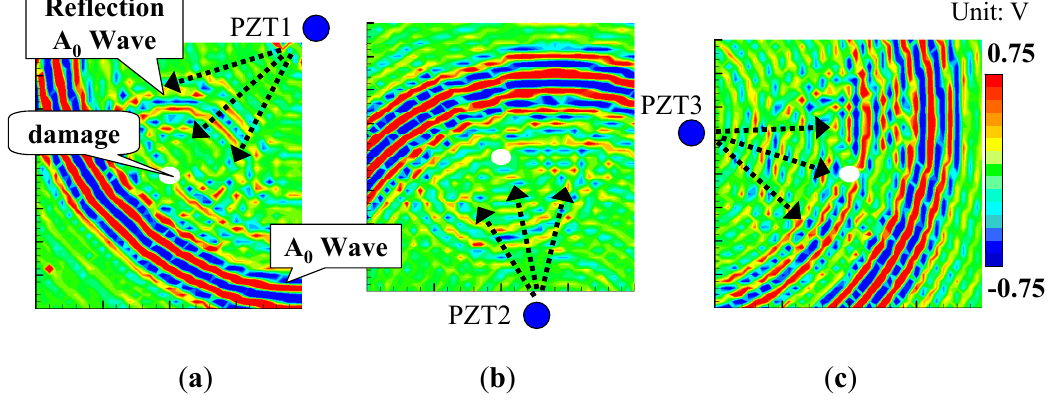
Figure 3. Experimental images of Lamb waves (time = 70 μ s) using previous technique [19–21] for the aluminum plate with an elliptical through-hole: ( a ) PZT-1; ( b ) PZT-2; ( c )